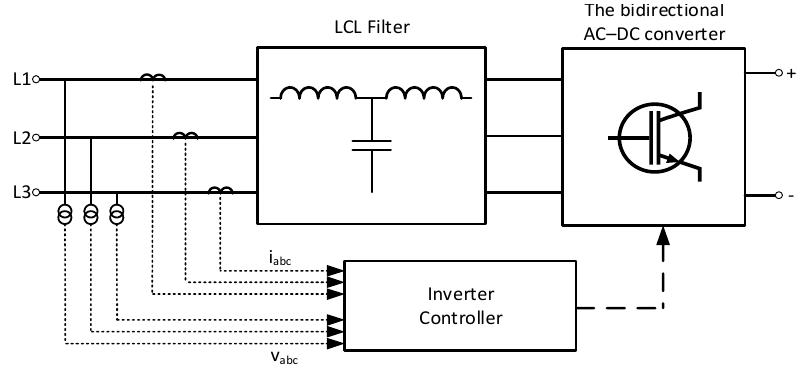
Figure 8. Model of an active rectifier with a MOSFET bridge .